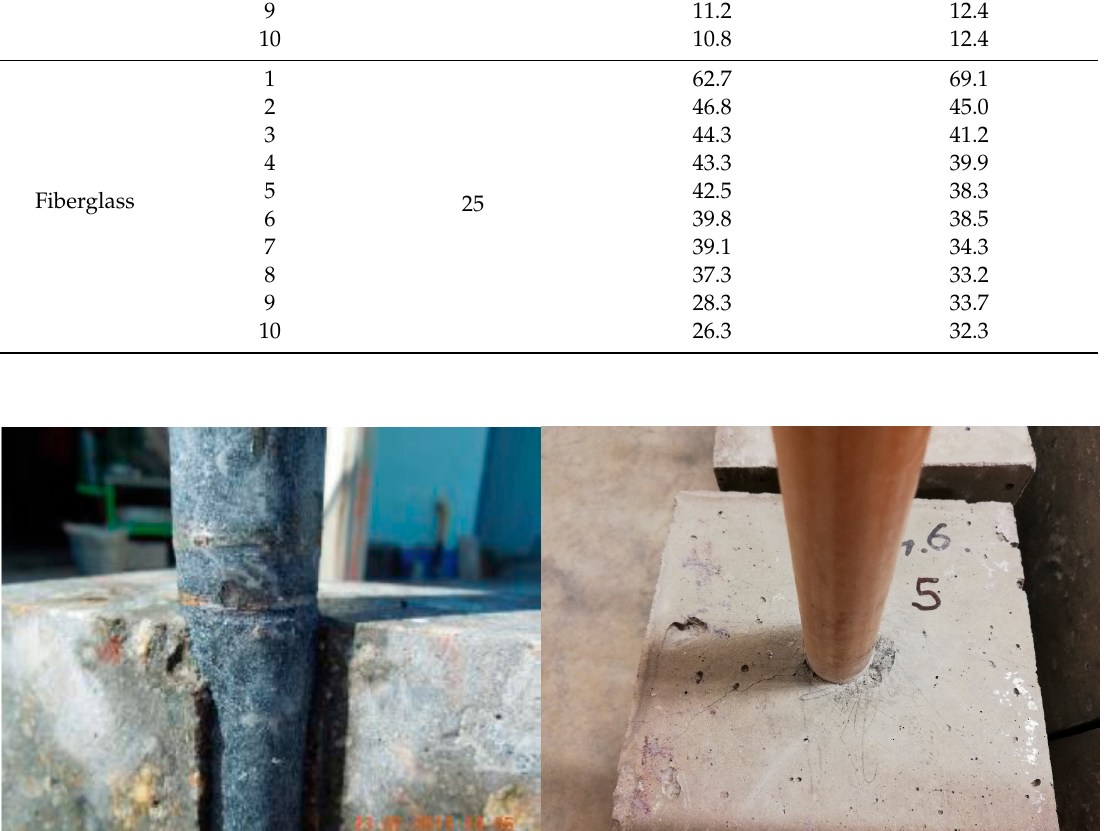
Table 5. Stress distribution at faces of concrete beams, force 10 kN. No.